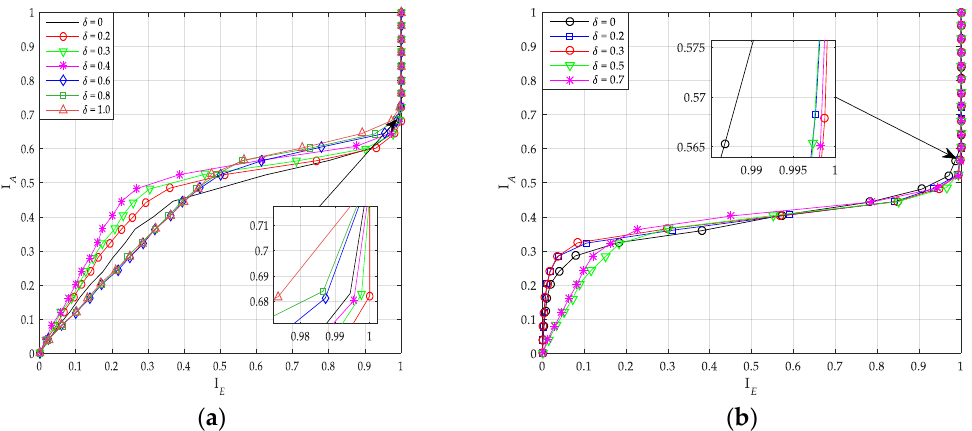
Figure 11. Transfer characteristics of PIC PCCA-polar code with different  . ( a ) K = 100, R = 1/2; ( b ) K = 64, R = 1/3. ( b ) K = 64, R = 1 / 3. Sensors 2020 , 20 , x FOR PEER REVIEW